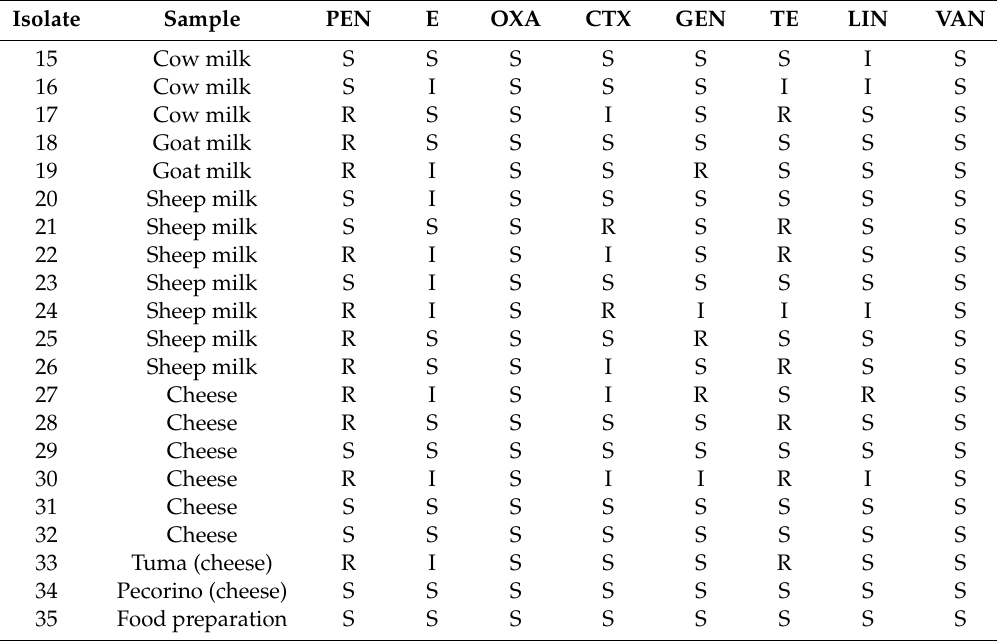
Table 2. Antimicrobial resistance profile of animal-derived isolates. The following antibiotics were tested using the Kirby–Bauer method: penicillin (PEN), erythromycin (E), oxacillin (OXA), ceftriaxone (CTX), gentamicin (GEN), tetracycline (TE), lincomycin (L), and vancomycin (VAN). The susceptible (S), intermediate (I), and resistant (R) phenotypes are